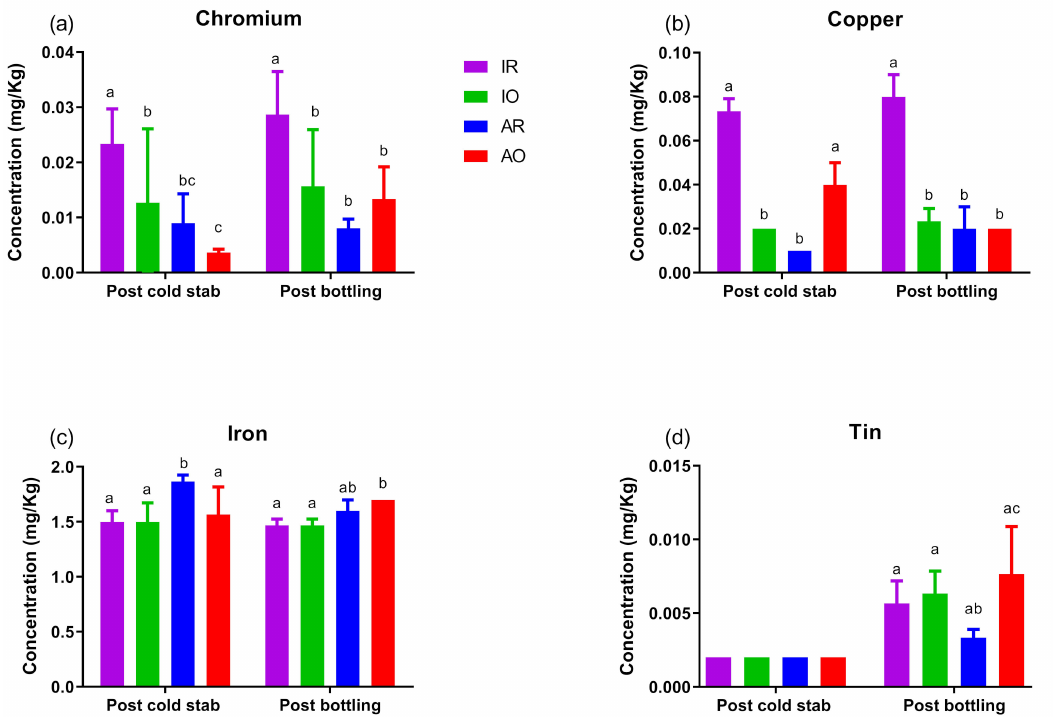
Figure 6. E ff ects of oxygen exposure during pressing and handling on the concentration of Cr ( a ), Cu ( b ), Fe ( c ) and Sn ( d ) in finished Chardonnay wines for inert pressing–reductive handling (IR, purple), inert pressing–oxidative handling (IO, green), aerobic pressing–reductive handling (AR, blue), and aerobic pressing–oxidative handling (AO, red) treatments. Significant di ff erences between treatments are indicated by di ff erent letters above each bar graph as determined by